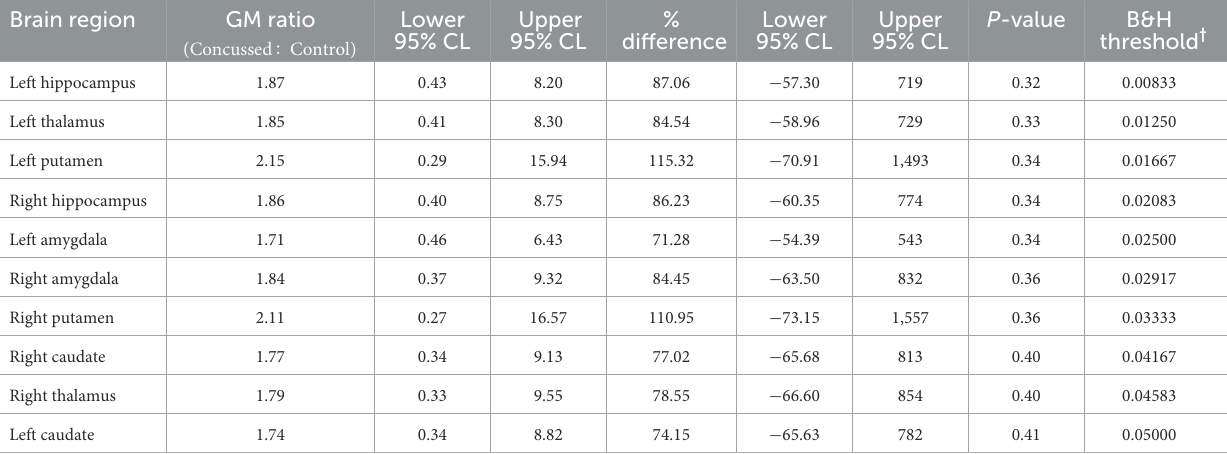
TABLE 3 Comparison of the distribution of VT between MAB concussed and MAB control subjects based on 2-sample Welch parametric t -test. Brain